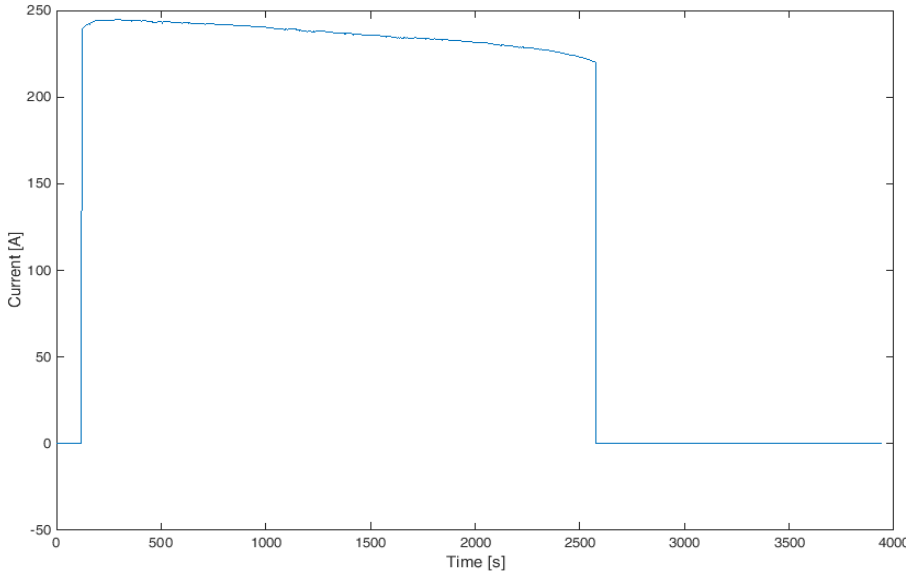
Figure 17. The current profile of the battery module during the 2C-rate discharge test.